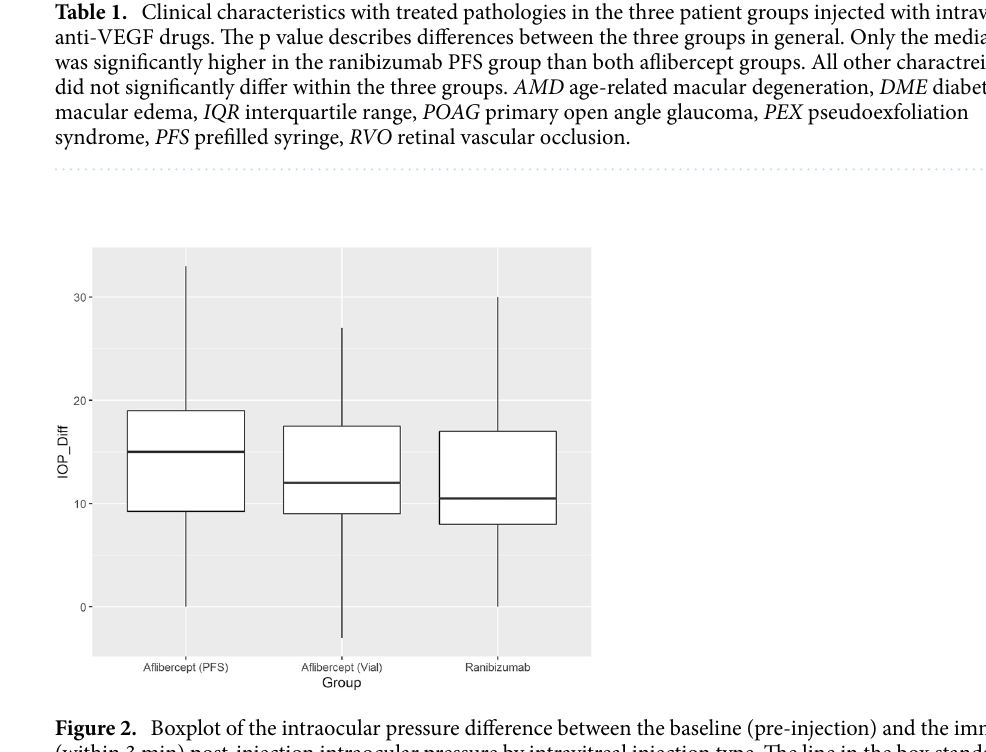
Aflibercept PFS Aflibercept vial Ranibizumab